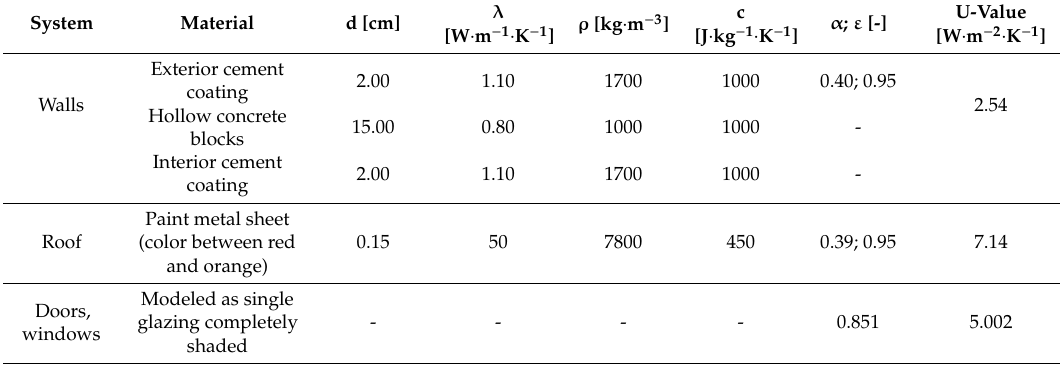
Table 1. Thermal properties of building materials adopted for the modeling